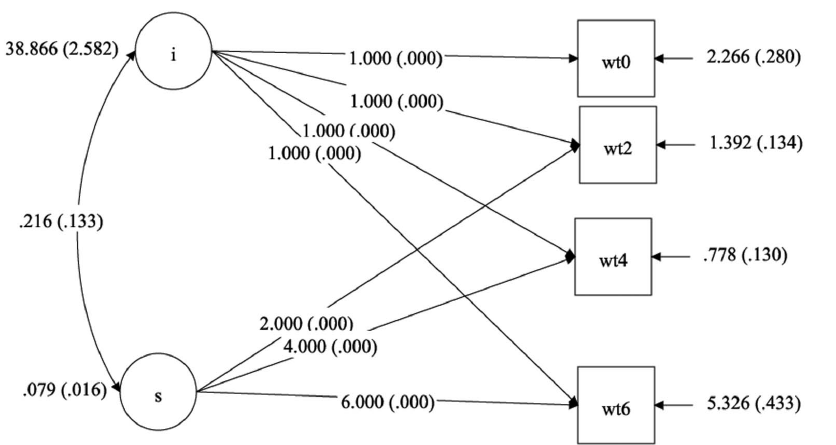
Figure 4. Linear latent growth model of weight change in TB patients over time. Legend: i - intercept of linear latent growth model of weight change in TB patients. s - slope of linear latent growth model of weight changes in TB patients. wt0 - weight of TB patients in kilograms at the initial stage of anti TB treatment. wt2 - weight of TB patients in kilograms at 2 nd month of anti TB treatment. wt4 - weight of TB patients in kilograms at 4 th month of anti TB treatment. wt6 - weight of TB patients in kilograms at 6 th month of anti TB treatment.